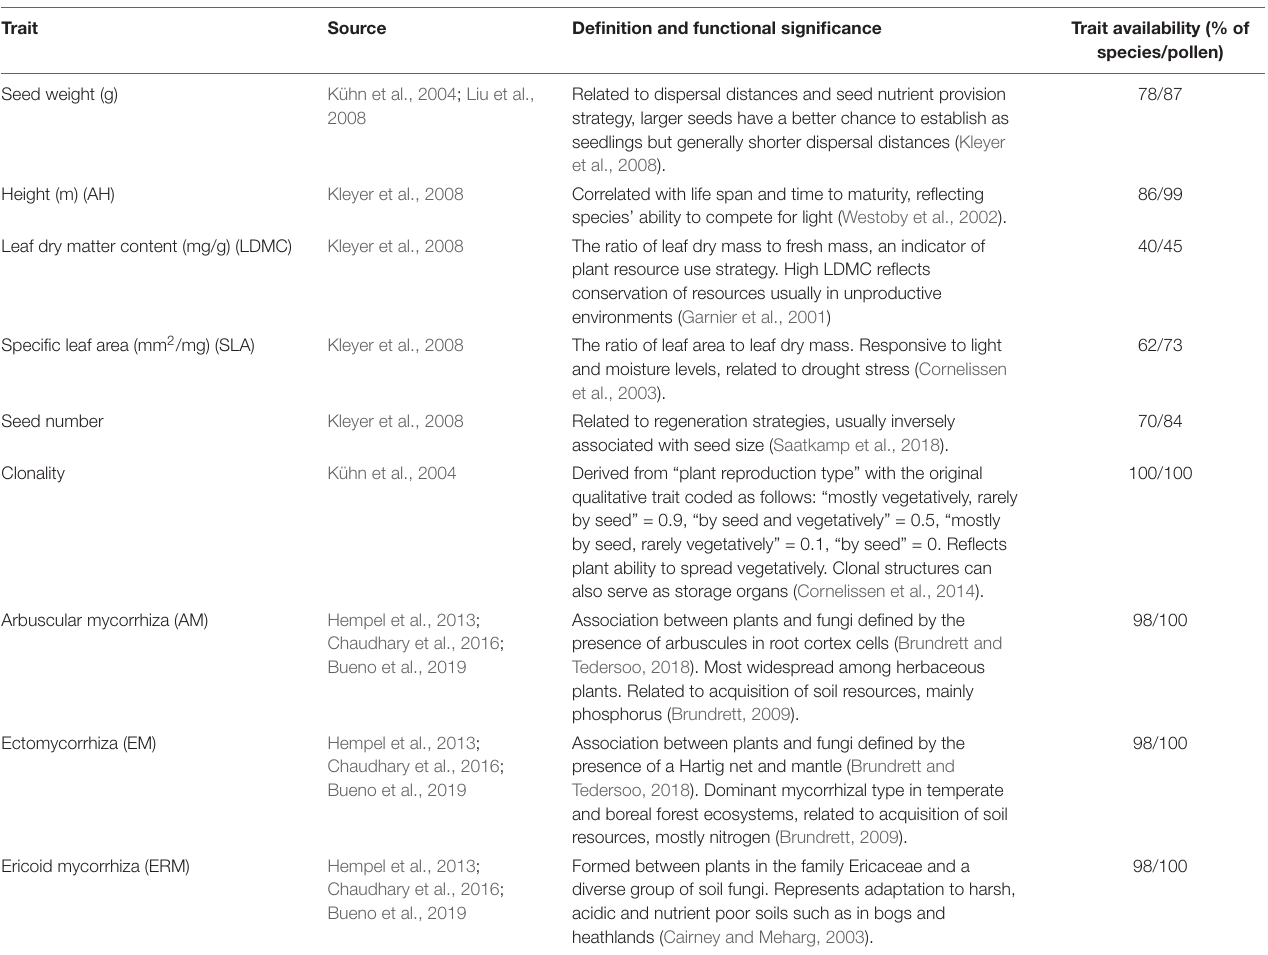
TABLE 1 | Plant traits used to examine functional composition (CWM) and alpha diversity (FDa) of pollen and plant